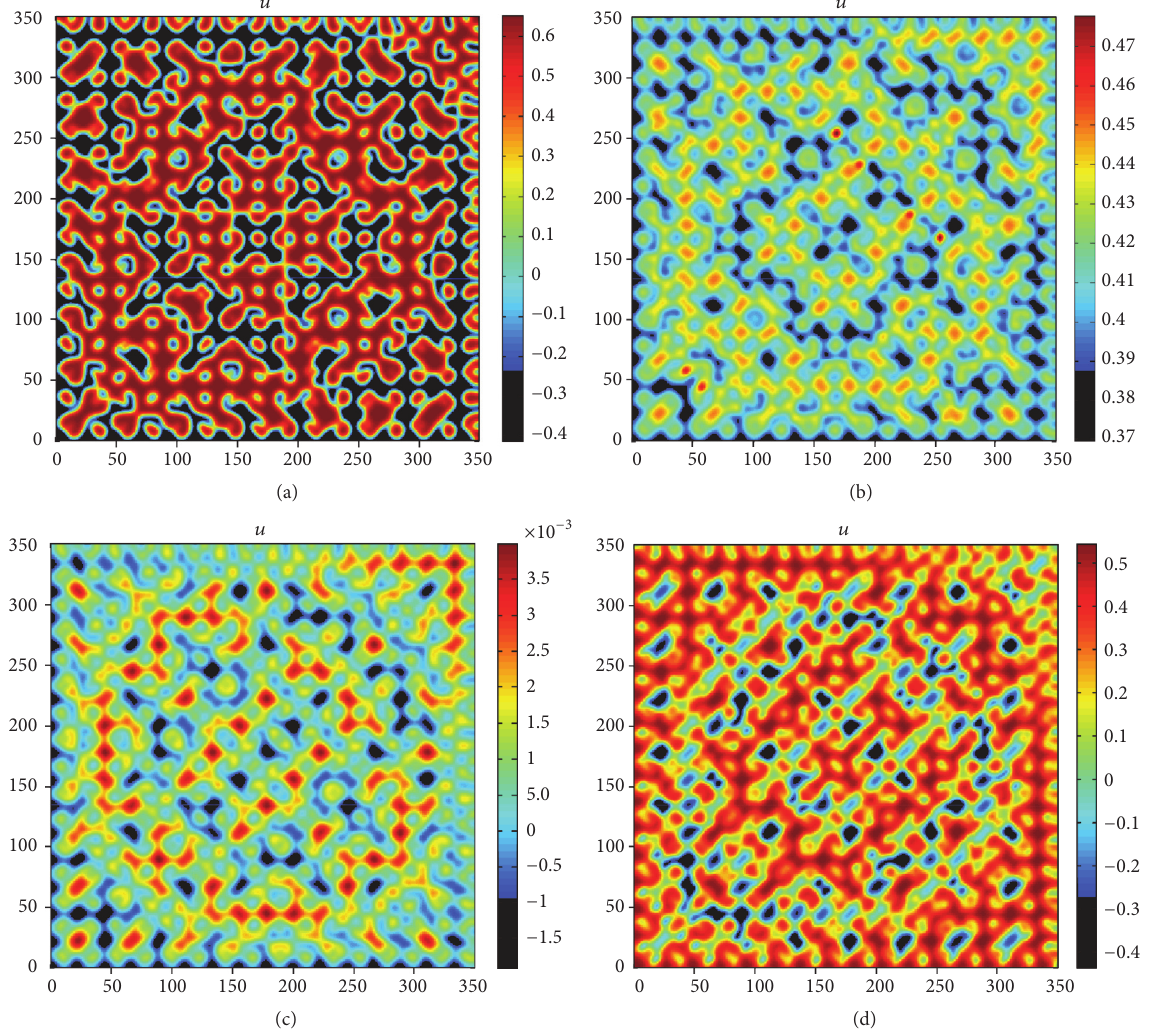
Figure 3: Parameter values and initial perturbation, respectively: 𝛼 = 3 , 𝛾 = 1 , 𝑑 1 = 1 , 𝑑 3 = 1 , 𝜎 = 1/2 , 𝑑 2 = 0.1 , sin (𝑥𝑦) , and cos (𝑥𝑦) . (a) Pattern formation on the top domain when 𝑑 4 = 0.1 , 𝛽 = 4 . (b) Pattern formation on the right domain when 𝑑 4 = 1 , 𝛽 = 2 . (c) Pattern formation on the left domain when 𝑑 4 = 0.1 , 𝛽 = 2 . (d) Pattern formation on the bottom domain when 𝑑 4 = 1 , 𝛽 = 2